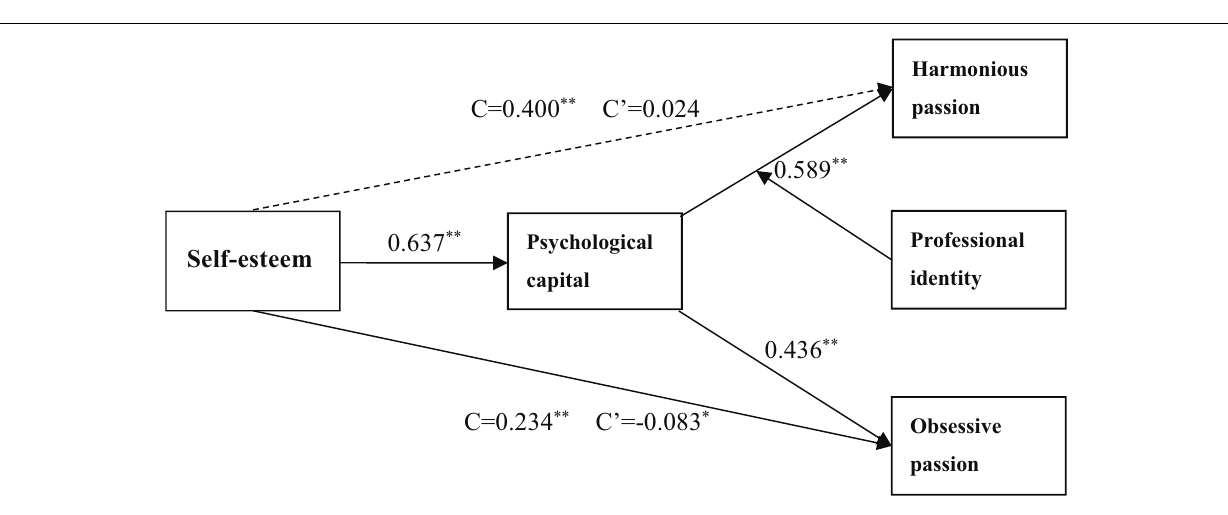
FIGURE 3 | Modified model and standardized path coefficients. C is the total effect of self-esteem on harmonious passion and obsessive passion. C’ is the direct effect of self-esteem on harmonious passion and obsessive passion. * p < 0.05, ** p < 0.01, Correlation is significant at the 0.01 level